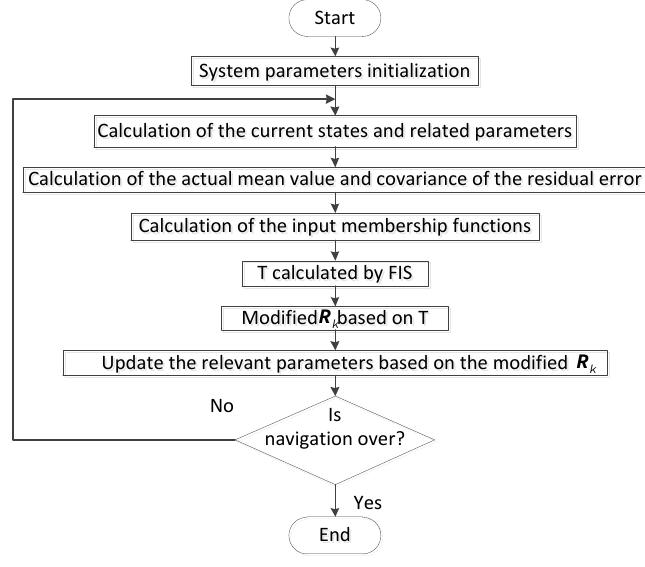
Figure 4. Flow chart of the modified fuzzy adaptive Kalman filter.